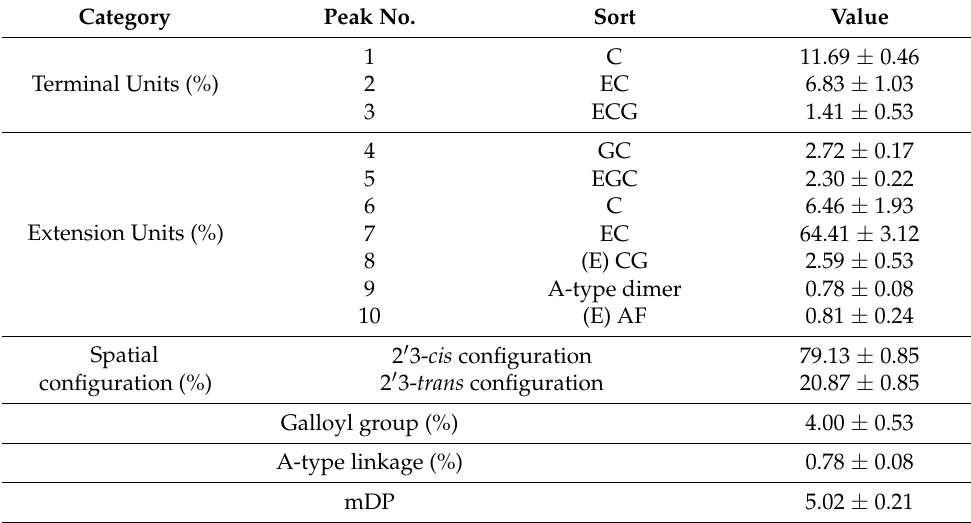
Table 8. Analysis results of benzyl mercaptan degradation products of the 70% acetone eluent of the rhizome of F. dibotrys by